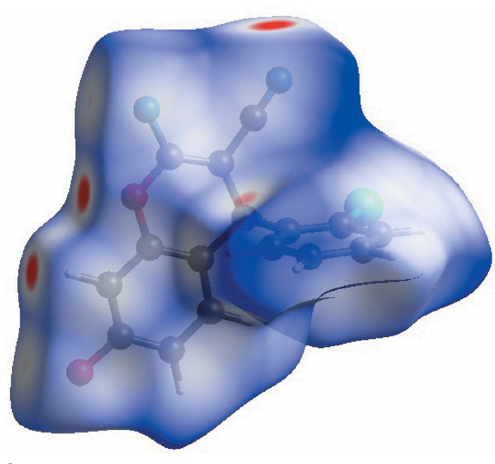
Figure 6 Hirshfeld surface mapped over d norm in the range (cid:4) 0.6146 to 1.6047 a.u.